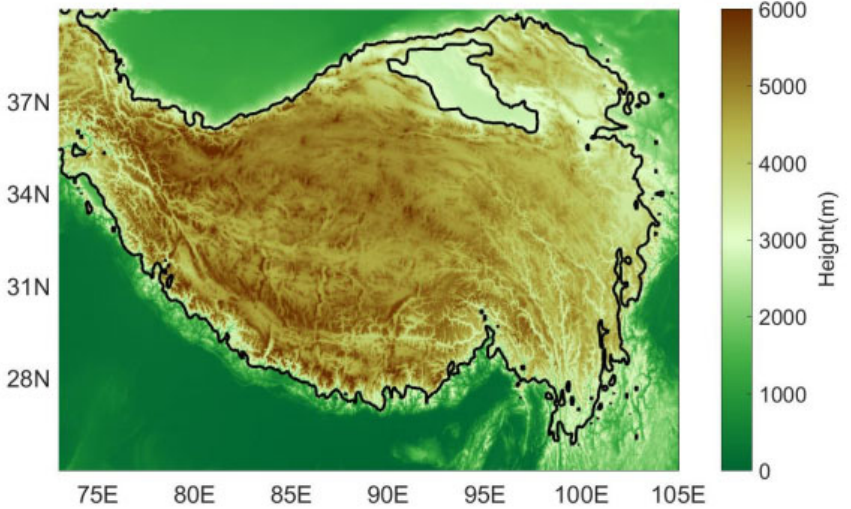
Figure 1. The area of the Qinghai–Tibet Plateau.(Units: latitude is °N, and longitude is °E).